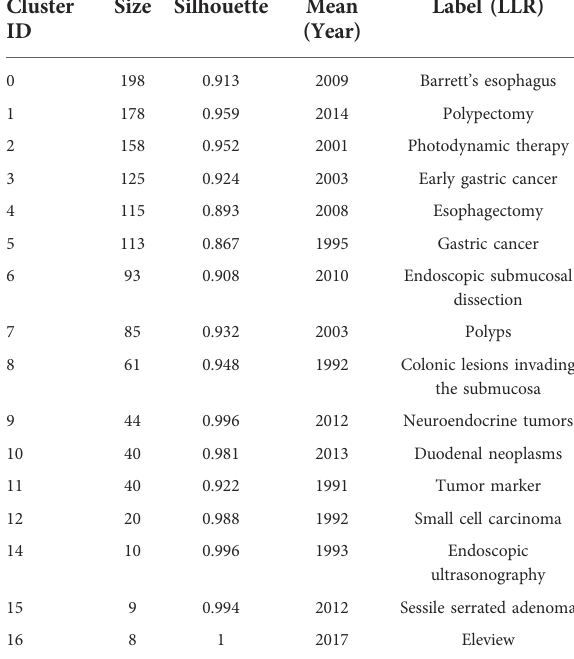
TABLE 6 The cluster